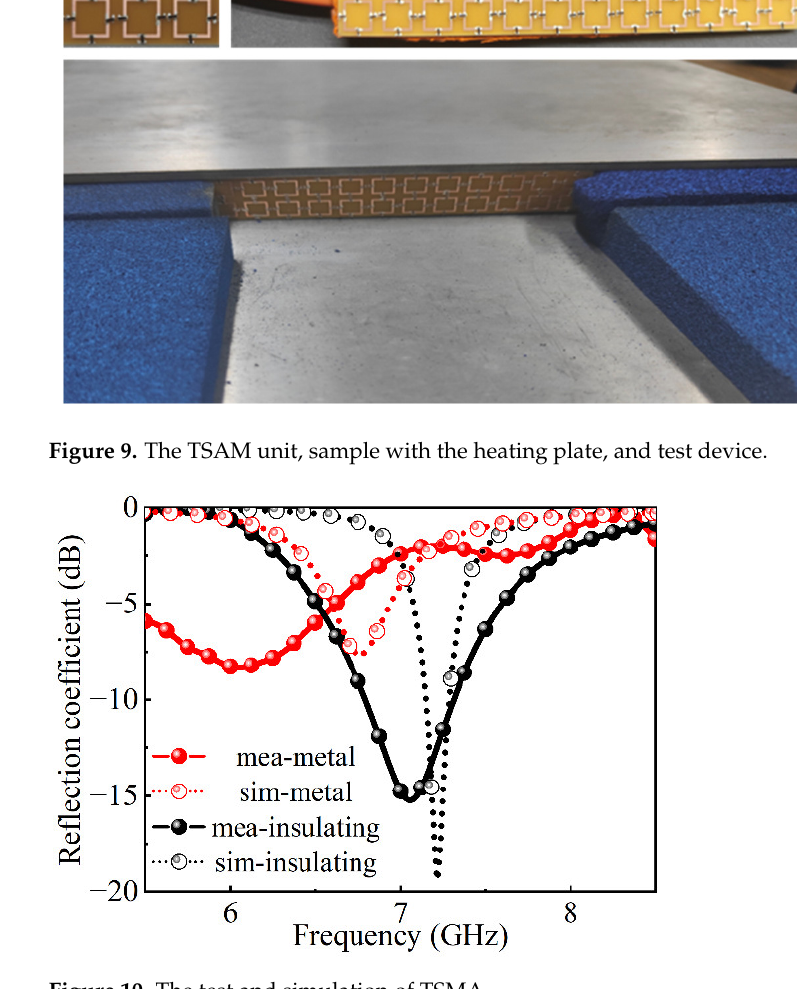
Figure 10. The test and simulation of TSMA.